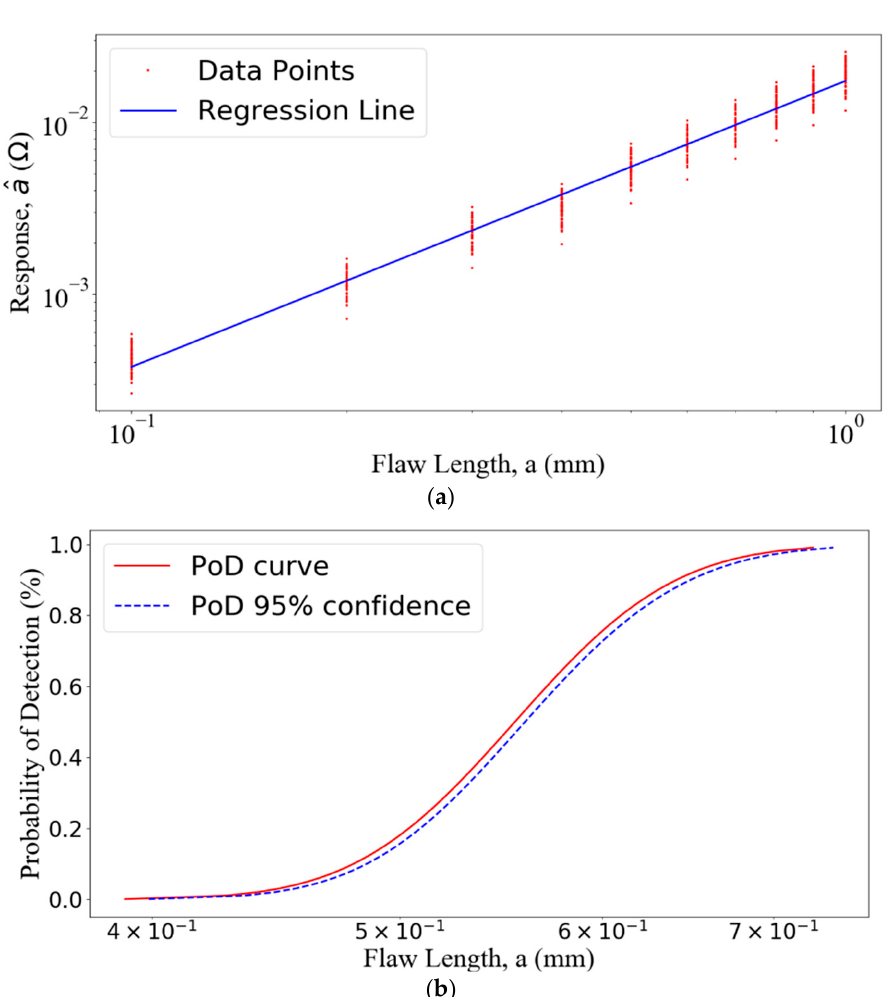
ˆ Figure 7. ( a ) The “ ˆ a vs. a ” regression analysis and ( b ) PoD curve with a lower 95% confidence a vs. a ” regression analysis and ( b ) PoD curve with a lower 95% confidence bound. Figure 7. ( a ) The “ bound. The three key PoD metrices The three key PoD metrices a 50 , a 90 , and a 90_95 are 0.555 mm, 0.641 mm, and 0.650 mm,